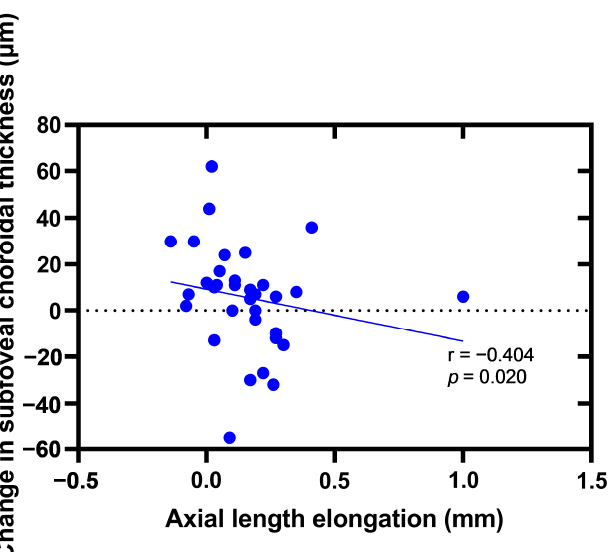
Figure 4. The correlations between the axial length elongation and the changes in the subfoveal thickness at nine-month follow-up.